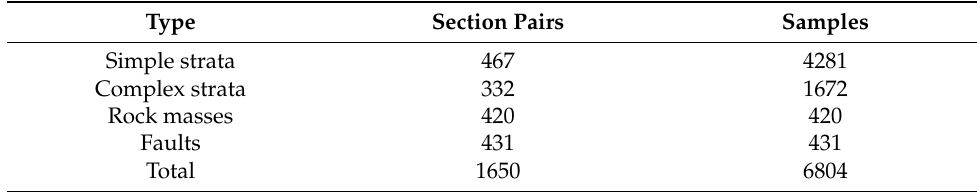
Table 1. The amount of collected data for training.